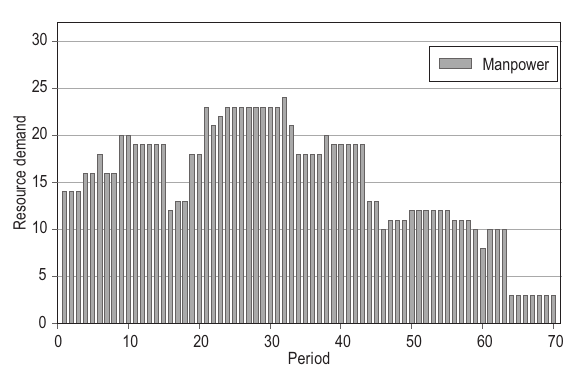
Fig. 6. Project resource profile after being optimized by Table 4. Optimal start time (ST) for all activities found by FCDE-RL Act. ID